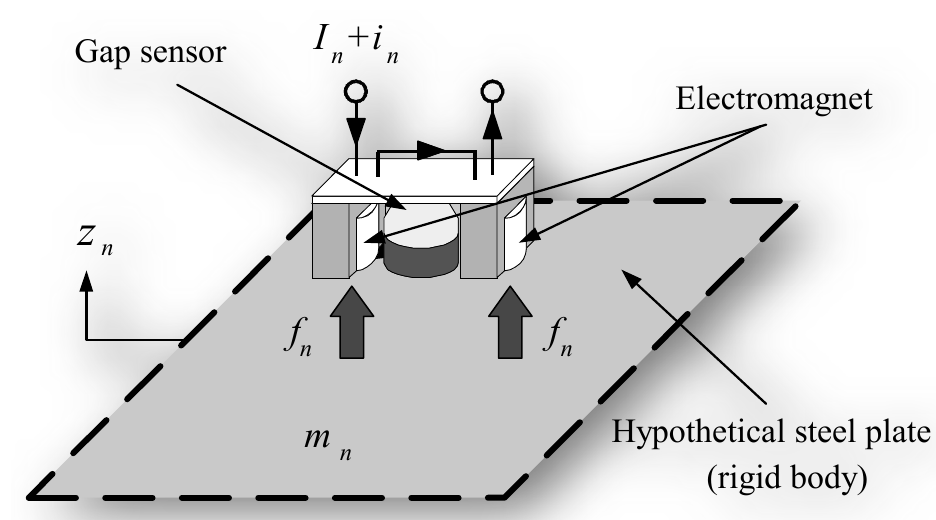
Figure 8. Theoretical model of levitation control.